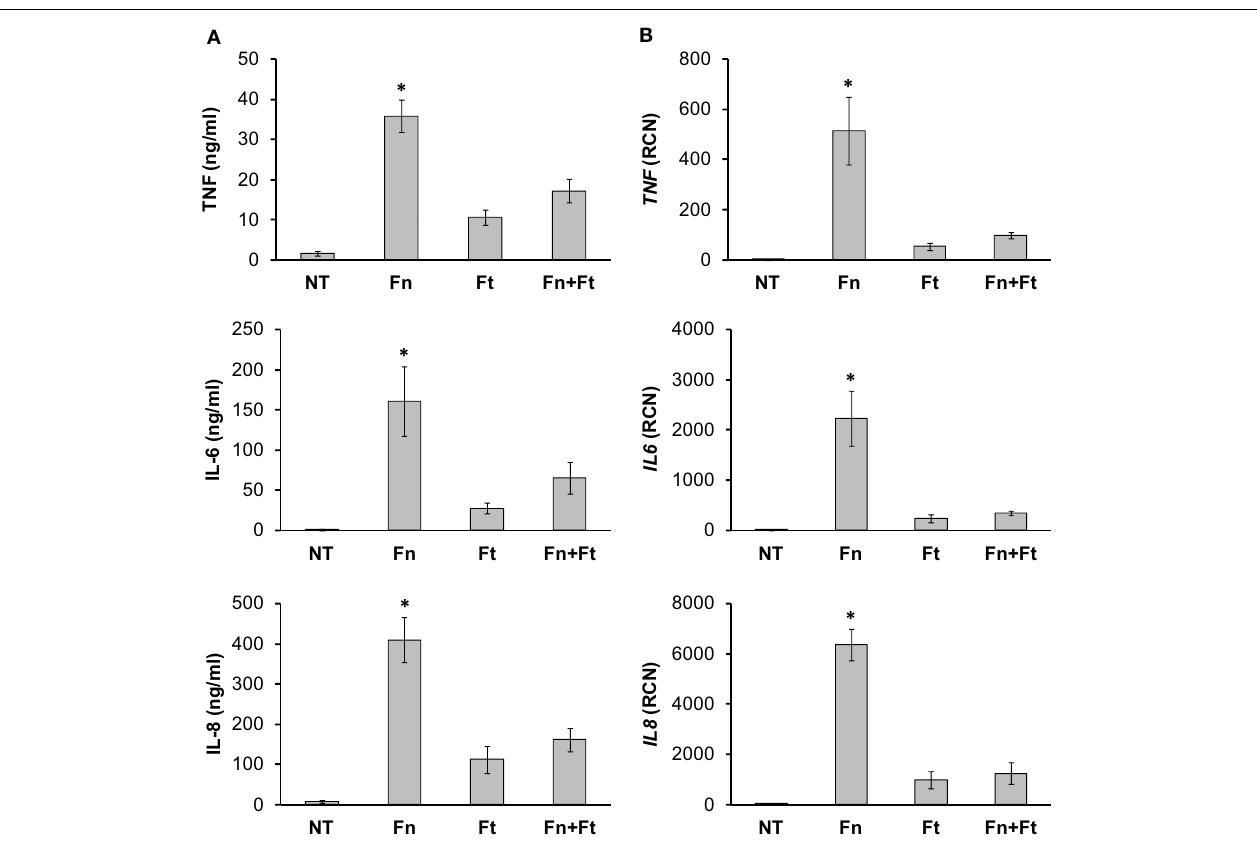
FIGURE 1 | Virulent strains of F. tularensis elicit a dampened cytokine response in monocytes. Primary human monocytes were left untreated (NT) or infected in triplicate for 16h with either F. novicida (Fn), F. tularensis Schu S4 (Ft), or both at an MOI of 50 for each bacteria. Cell-free supernatants from infected monocytes were collected and